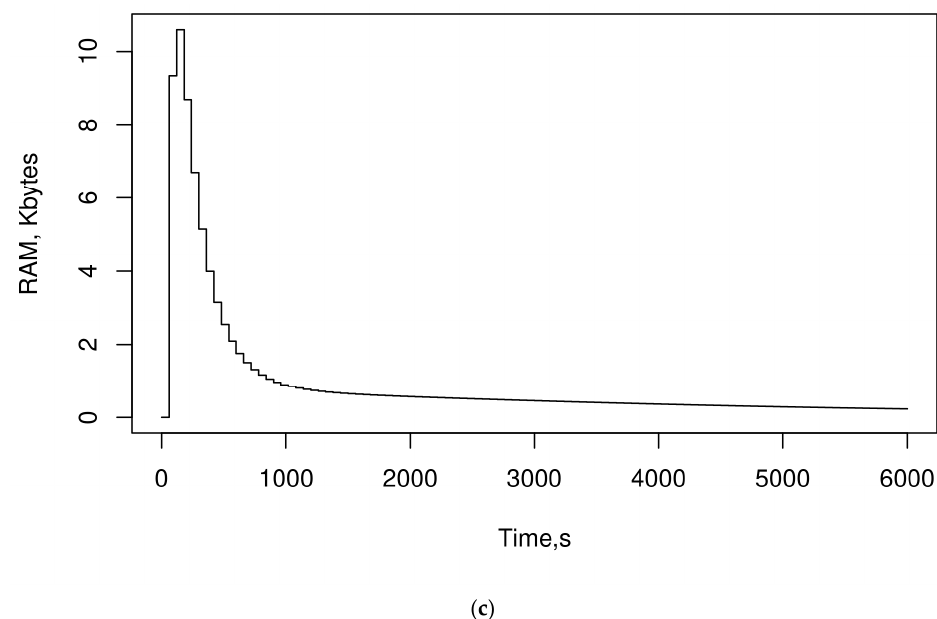
Figure 7. RAM utilisation of ( a ) BoT-IoT, ( b ) IoTID20 and ( c ) TON-IoT.